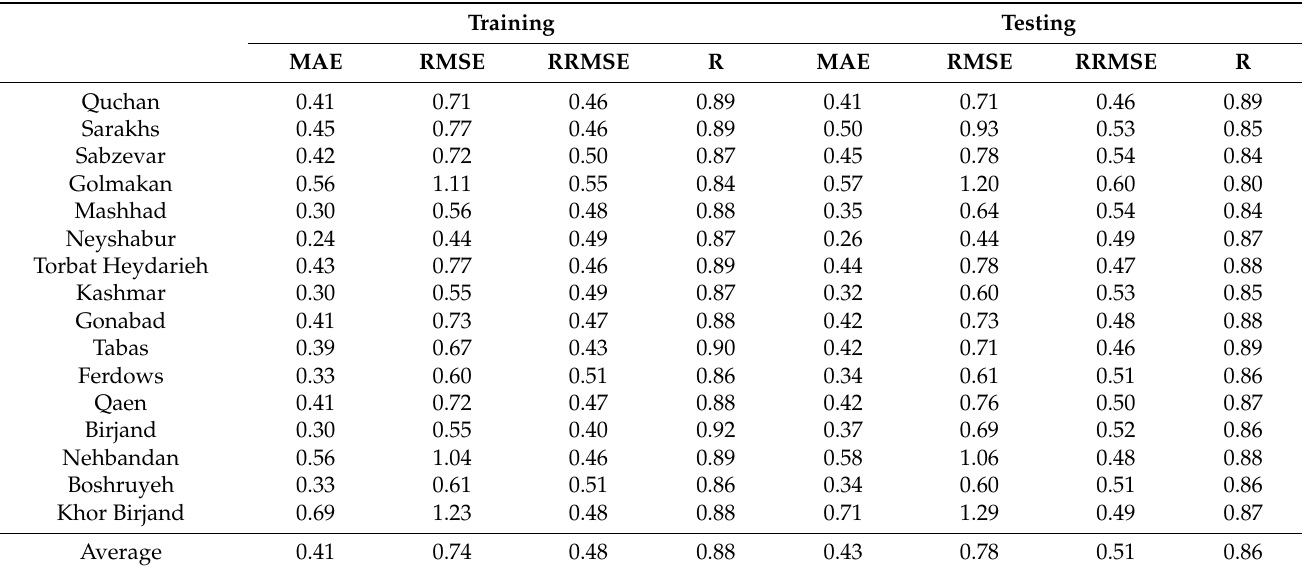
Table 4. Results of modeling WS with LSBoost (meta-algorithm) at the different stations. Training